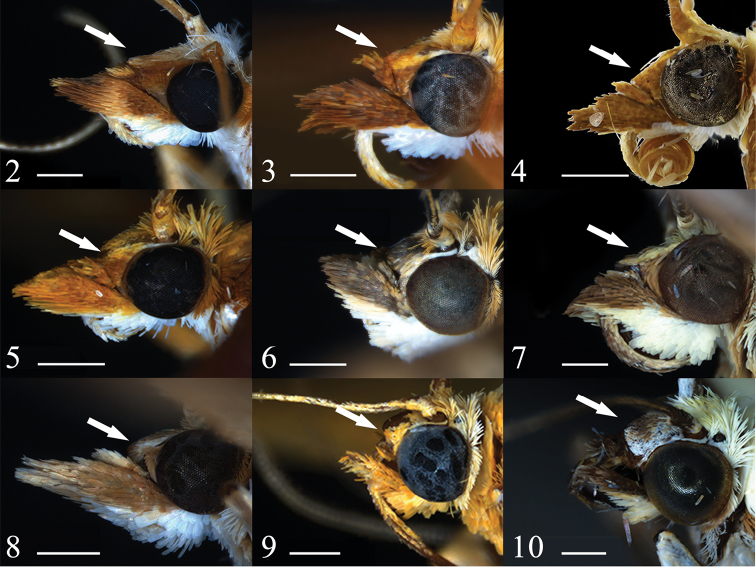
Head profiles of species of Emphylica, Loxostege, Achyra and Sitochroa2Emphylicadiaphana3E.crassihamata4E.cruoralis5E.xanthocrossa. 6Loxostegesticticalis7L.deliblatica8Achyramassalis9Sitochroaumbrosalis10S.palealis. Scale bar: 0.5 mm.